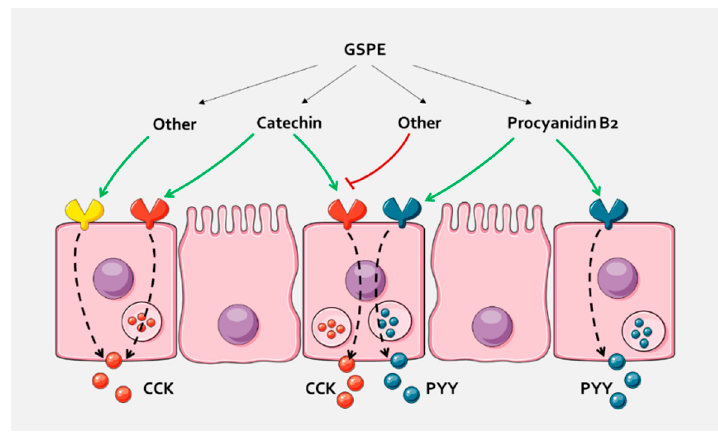
Figure 4. In pig duodenum, the different compounds of GSPE cause a selective enterohormone secretion. A possibility is that they act through different receptors that are related to a specific enterohormone secretion, either because they are expressed in cells containing only this hormone, or because they activate intracellular mechanisms that distinguish between hormones. Other compounds of the extract might antagonize the effects, or increase secretion through the same or other receptors. A similar pathway could take place in the colon, where differential GLP-1 and PYY secretion has been found.